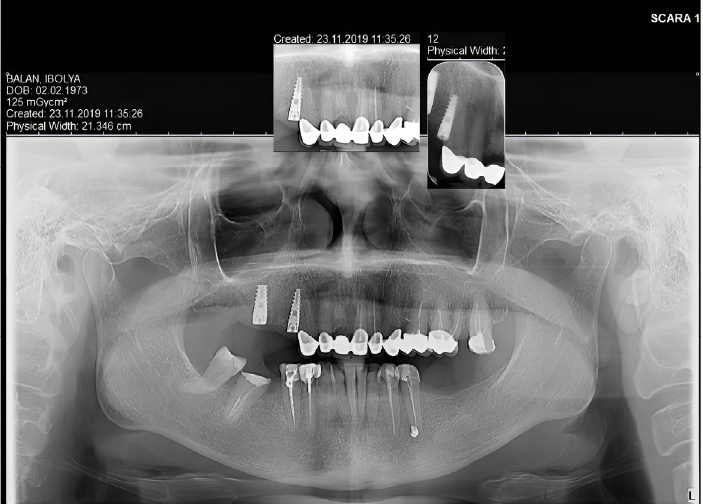
Figure 7. Panoramic X-ray with the osseointegrated implants and the maxillary prosthodontic rehabilitation on the natural teeth.